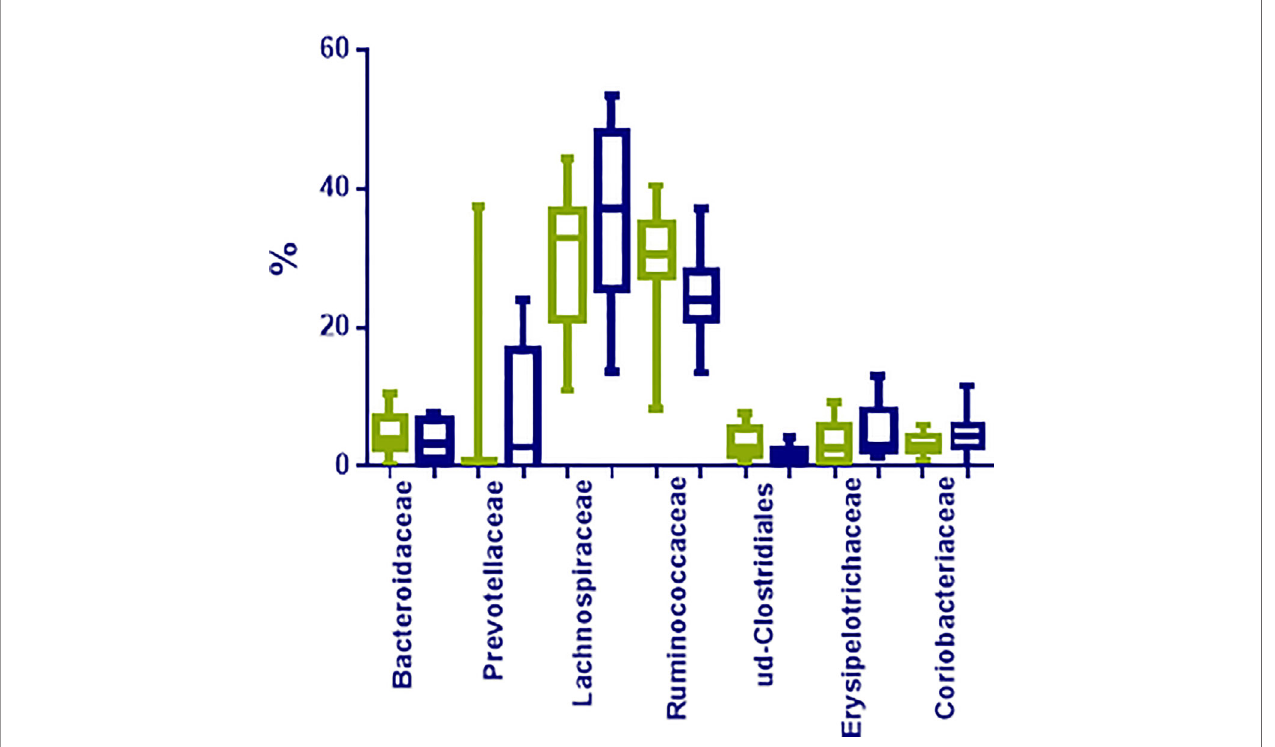
FIGURE 3 | Most represented groups at family level in fecal samples from normoweight (N, ) and obese (O, ) individuals. The median, minimum, and maximum values are